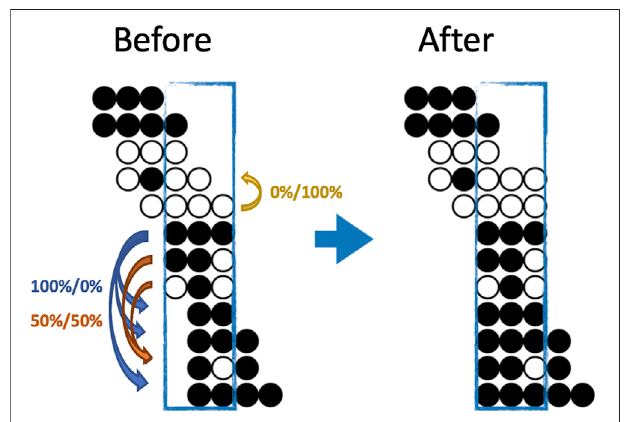
FIGURE 1 | An illustration of both the eligibility and a possible imputation result for BSImp. Given we are interested in window size of three cytosines, a region is selected as enclosed by a blue rectangle. Each line of dots represents a read aligned to a speci fi c genomic region; black (white) dots represents a methylated (unmethylated) cytosine for the given read. Four complete patterns are observed, which makes the window eligible for imputation. Within the window, only reads missing at most one methylation statuses (dots) are eligible for imputation; there are fi ve in the example. Looking at the topmost reads with one missing pattern, the rest of the pattern resembles that of the complete pattern below, so it has a probability of zero being methylated. The second last read has methylation pattern (black, white in the second and third position) resembles two other reads, which have methylation statuses of methylated and unmethylated, one each, so it has 50% of being